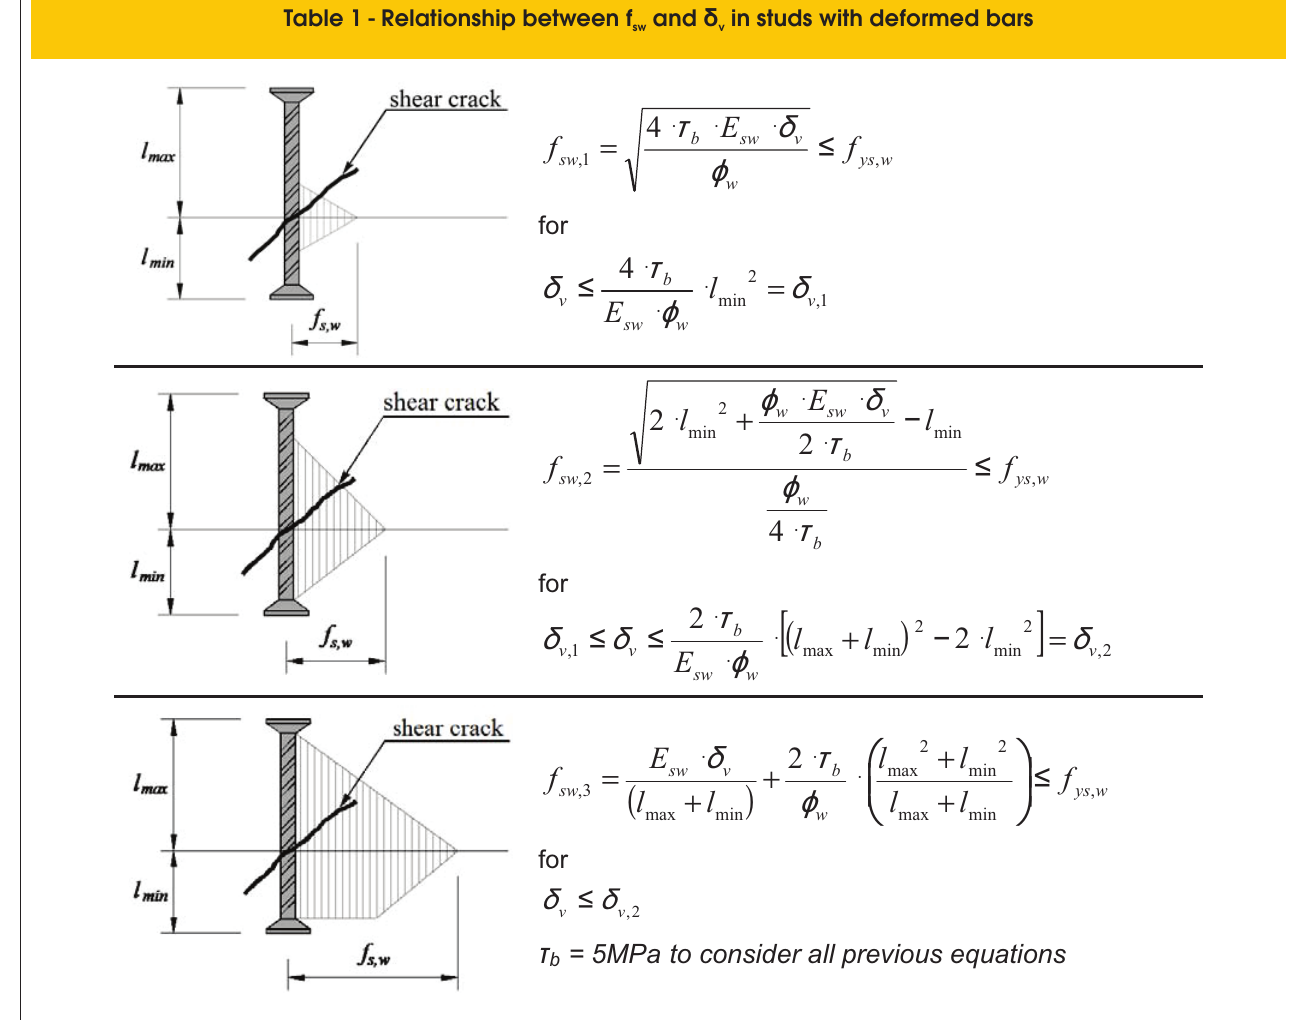
Table 1 - Relationship between f and δ in studs with deformed bars